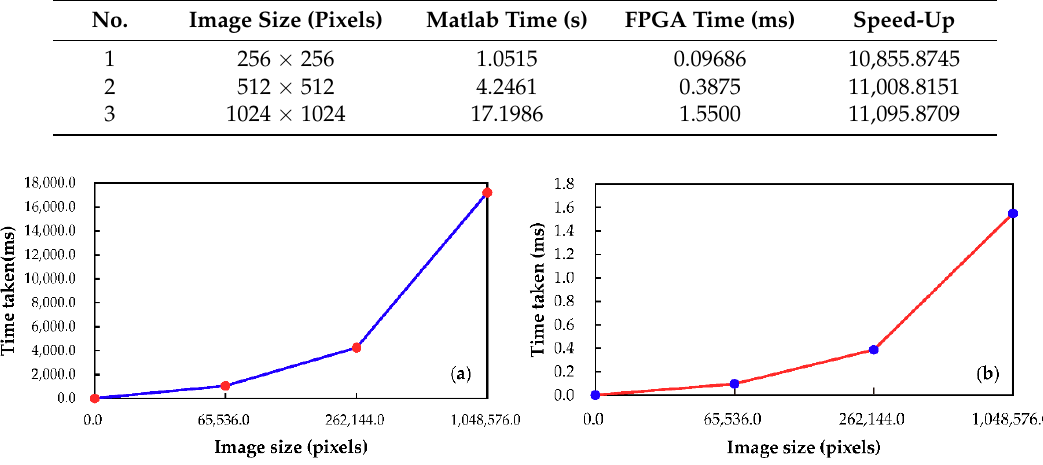
Figure 19. Image size vs. time taken to perform RPC orthorectification algorithm: ( a ) Matlab-based platform; and ( b ) FPGA-based platform.